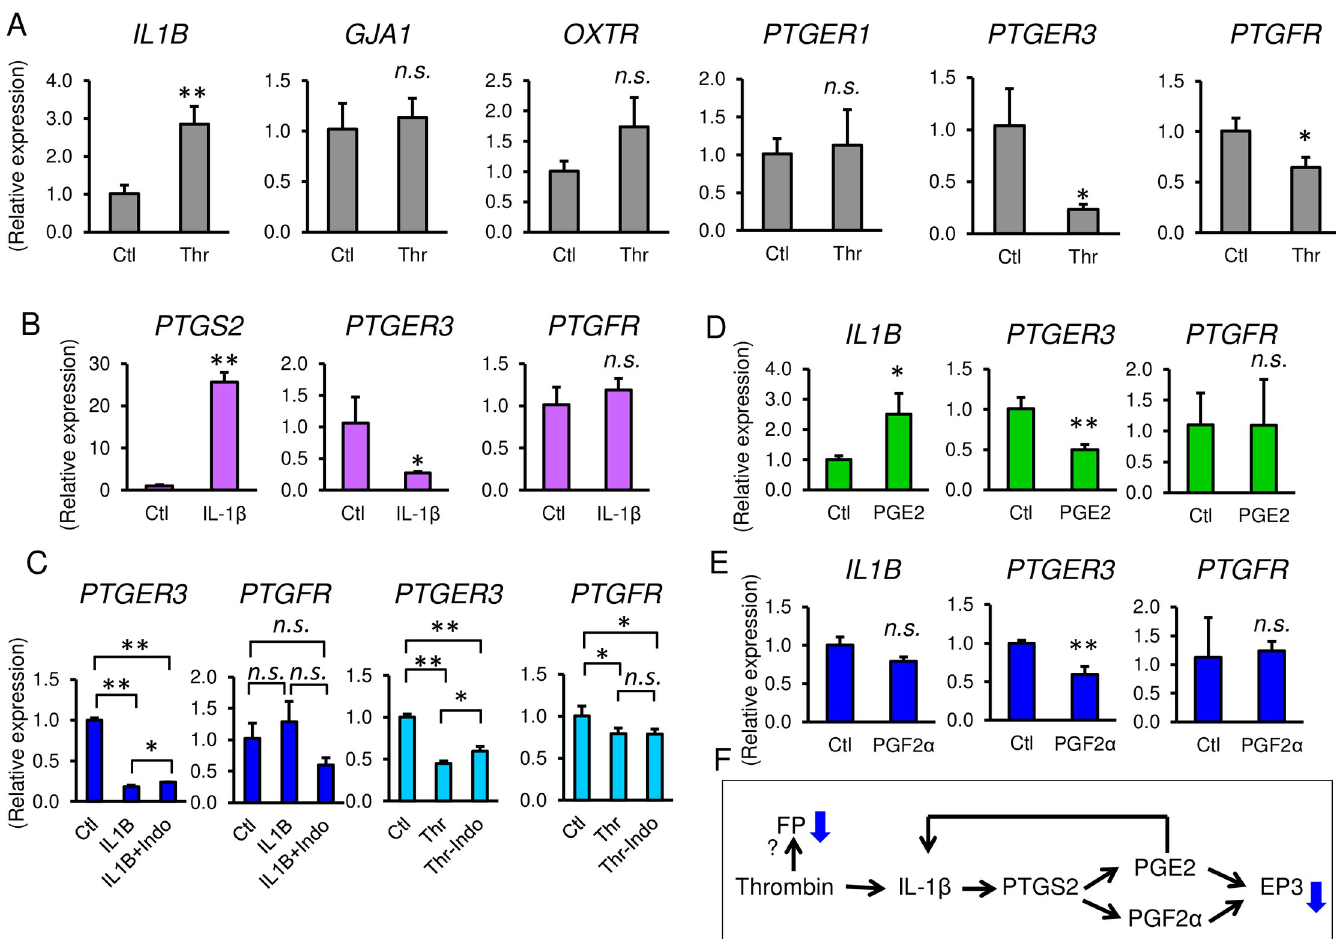
Fig 6. Effect of thrombin on contraction-associated proteins in myometrial cells. (A) IL1B , GJA1 , OXTR , PTGER1 , PTGER3 , and PTGFR mRNA gene expression in thrombin (2 U/mL)-treated myometrial cells at 24 h. n = 3 in each group. (B) Gene expressions of myometrial cells with treatment of 0.1 ng/mL of IL-1 β at 24 h. (C) mRNA expressions of PTGER and PTGFR with treatment of thrombin or IL-1 β , pretreated with indomethacin. (D) Gene expressions of myometrial cells with treatment of 0.1 μ M of PGE2 (D) or 0.1 μ M of PGF2 α (E) at 24 h. n = 3. � , p < 0.05, and �� , p < 0.01. (F) Scheme of regulation of contraction associated proteins by thrombin. The experiments were repeated three